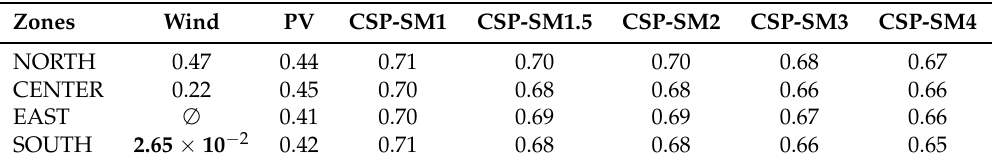
Table 7. Ratios (no units) given by (14) to identify the second capacity to be installed as the mean penetration is decreased from its